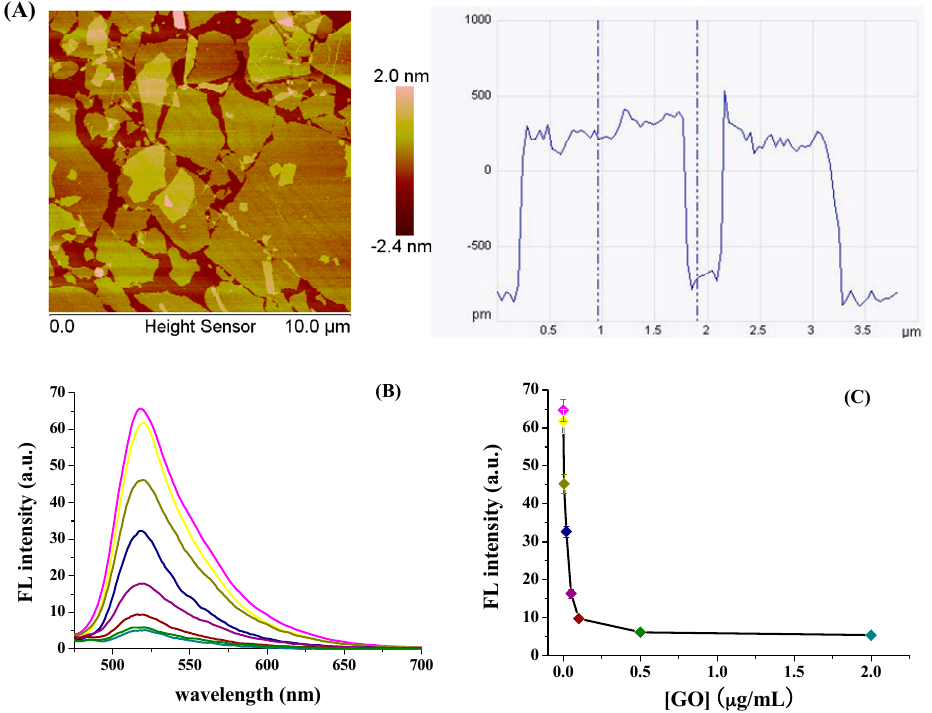
Figure 1. ( A ) AFM image and lateral size of GO; ( B ) Fluorescence spectra of 50 nM FITC-PPLRINRHILTR in the presence of different concentrations of GO; ( C ) Fluorescence intensity of FITC-PPLRINRHILTR versus the concentration of